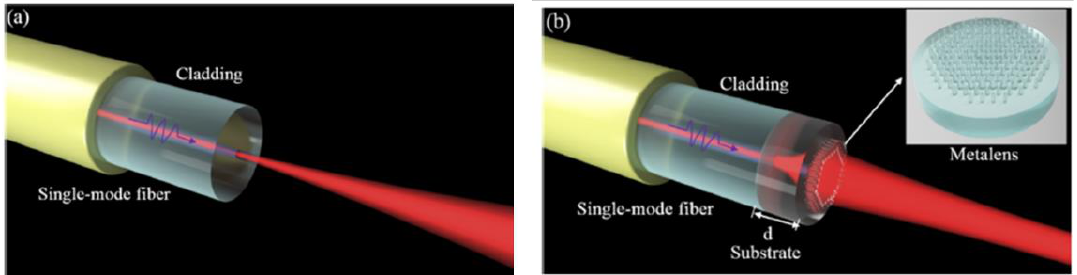
Figure 8. Light propagation through the SMF without ( a ) metasurface on the facet and ( b ) with metalens to control the light beam convergence. Reprinted with permission from Ref. [61]. Copyright 2021 Optical Society of America.